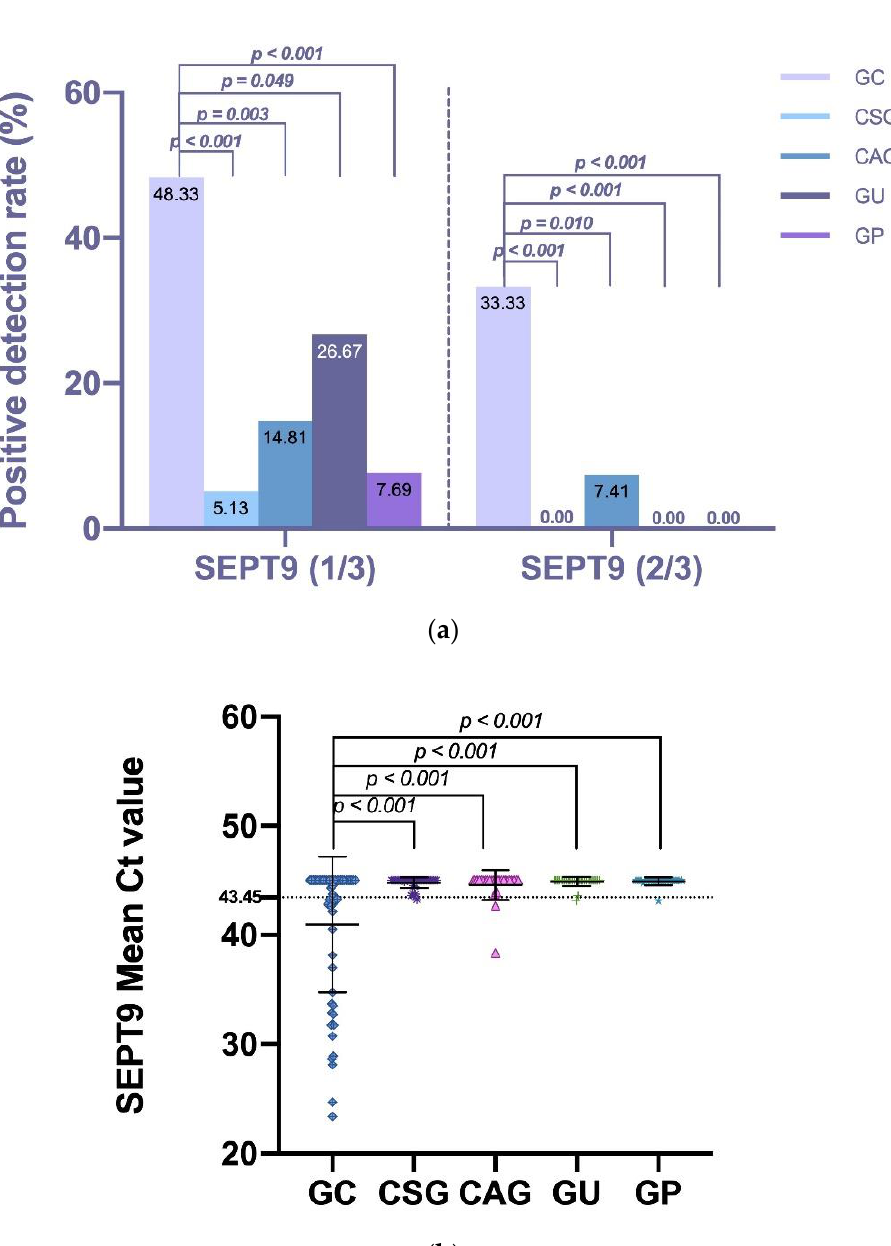
Figure 1. The positive rate and mean Ct value of mSEPT9 in each enrolled group. Different colors represent different groups. ( a ) The positive detection rate of mSEPT9 for each enrolled group based on the 2/3 or 1/3 algorithm. The positive detection rate was compared by the χ2 test or Fisher’s exact test. mSEPT9 level (1/3 and 2/3 algorithm) was significantly higher in the GC group than in the CSG, CAG, GU and GP groups. ( b ) The mSEPT9 mean Ct value for each enrolled group. The mean Ct value was compared by t tests. The mean mSEPT9 Ct value was significantly higher in the GC group than in the CSG, CAG, GU and GP groups. The mSEPT9 Ct cut-off value = 43.45 was calculated by the Youden index.